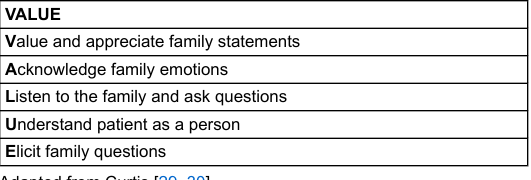
Table 2: The VALUE communication